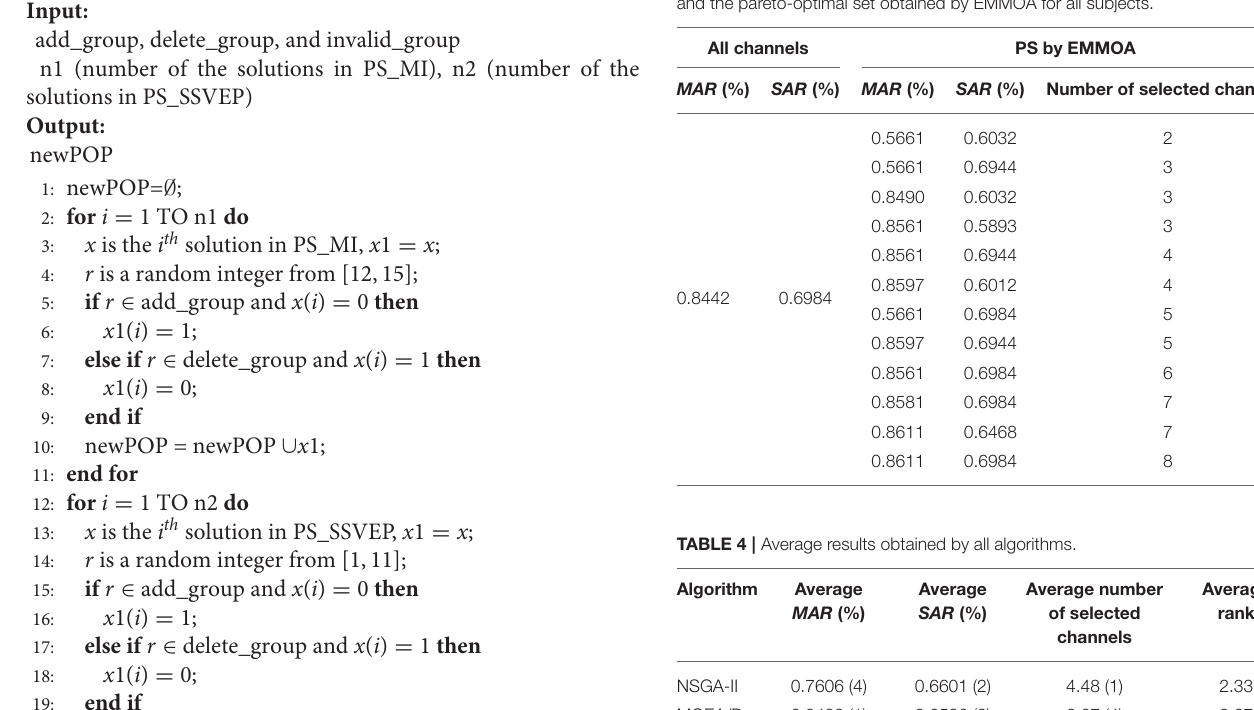
Algorithm 3 Detailed procedure of local searching operator.